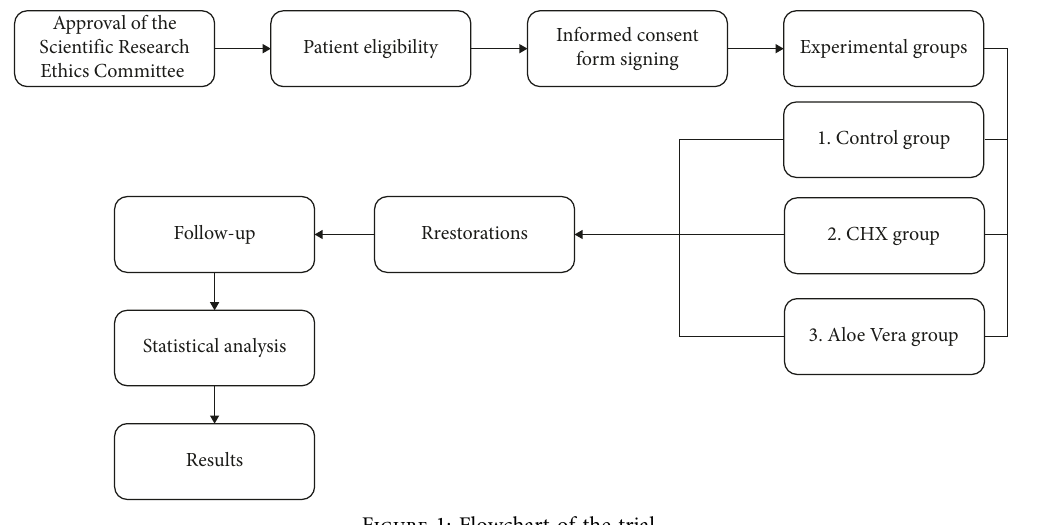
Figure 1: Flowchart of the trial. Table 1: Number (and percentage) of failures and successes of all experimental groups. Experimental group